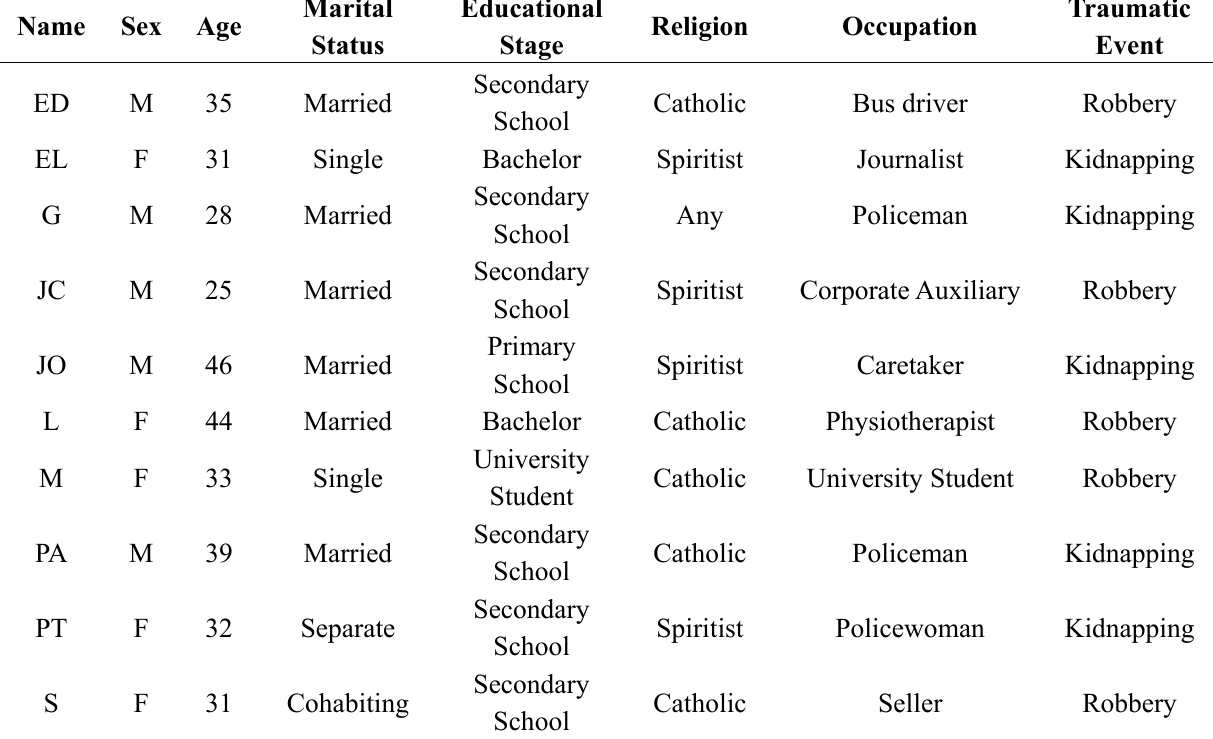
Table 1. General Description of Interviewees. São Paulo/SP,